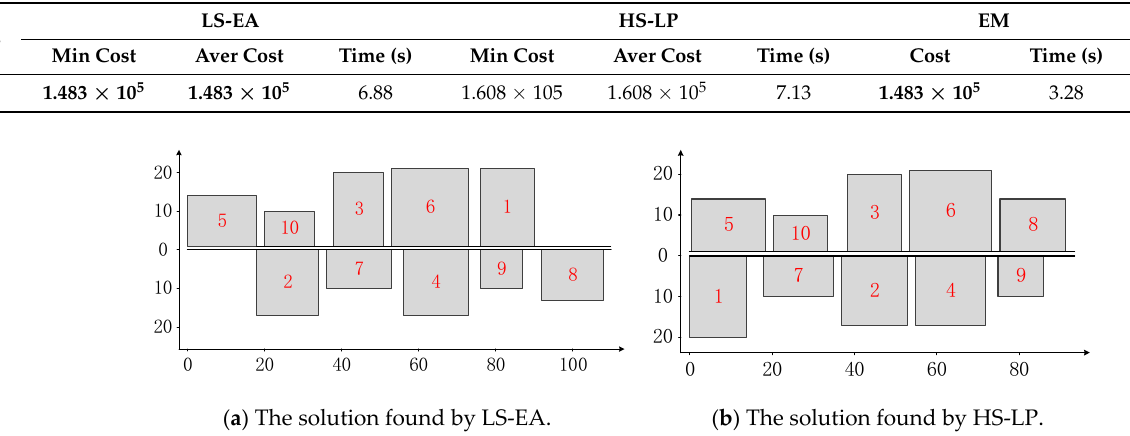
Table 4. Results of problem instance P10.